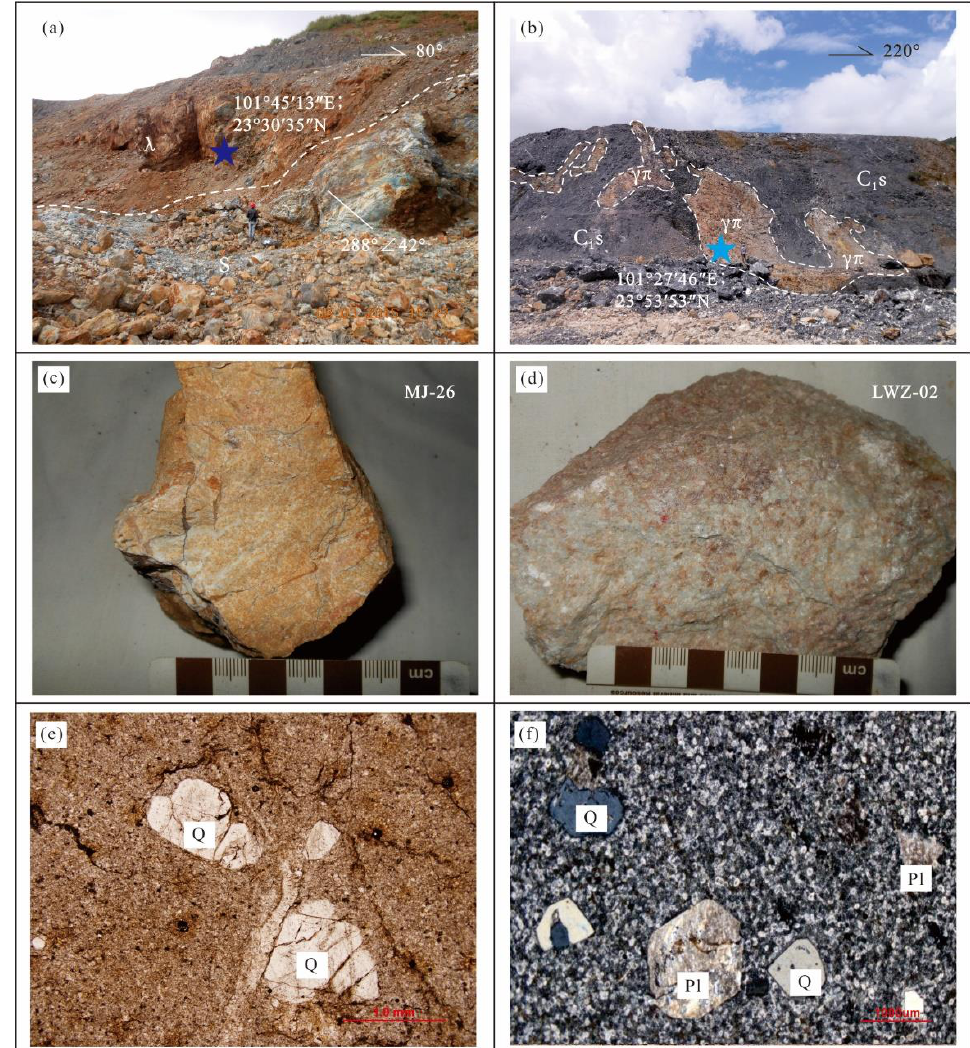
Figure 3. Field photos, hand specimens, and micrograph of the rhyolite in Mojiang gold deposits and the granite porphyry in Zhenyuan gold deposits. ( a ) Angular unconformity contact between rhyolite and Silurian strata; ( b ) Granite porphyry dike in Laowangzhai Mine; ( c ) Photograph of hand specimen of rhyolite (MJ-26) used for zircon U-Pb dating; ( d ) Photograph of hand specimen of granite porphyry (LWZ-02) used for zircon U-Pb dating; ( e ) Rhyolite phenocrysts are subrounded corroded quartz crystals; ( f ) Granite porphyry phenocrysts are sericitized feldspar and corroded quartz crystals. Q — quartz; Pl — plagioclase.